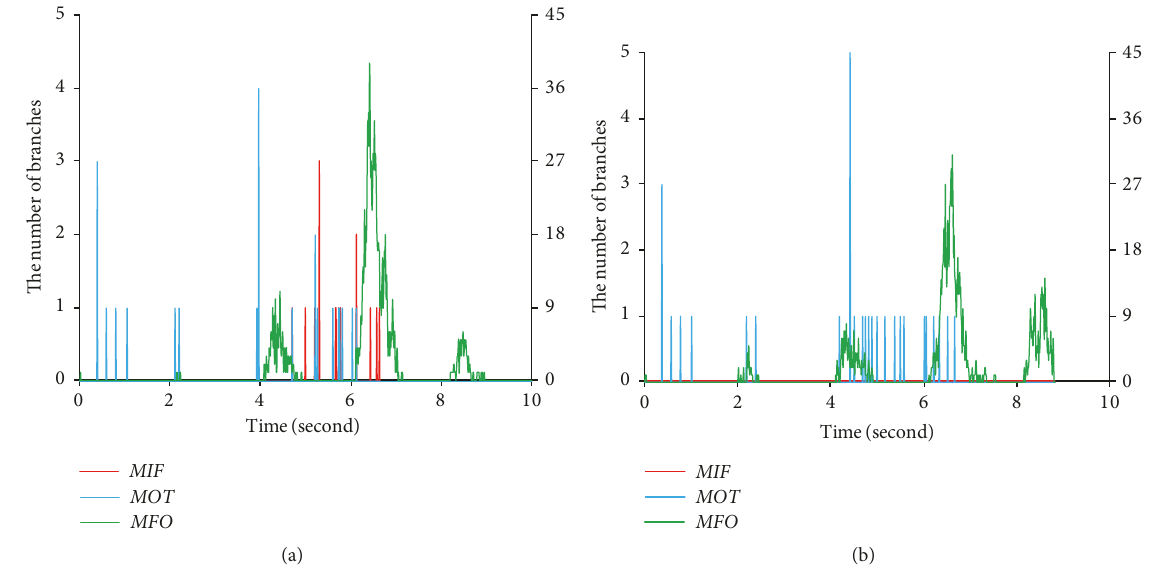
Figure 8: Numbers of different types of fault branches over time based on SIR model. (a) Scale-free network; (b) small-world